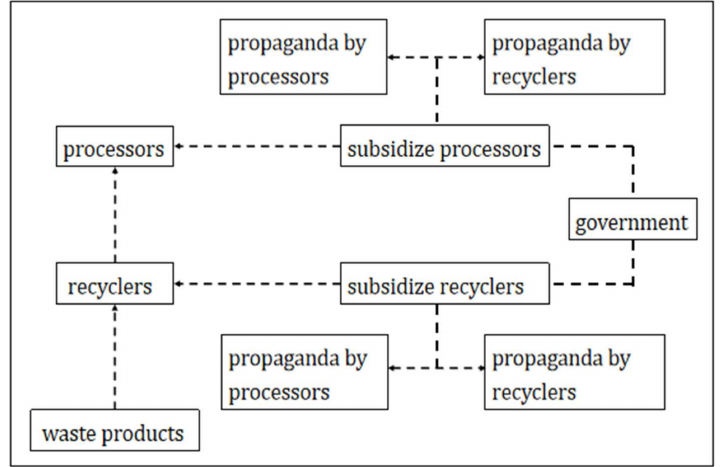
Figure 1. Game diagram of single-channel recycling with government subsidies and